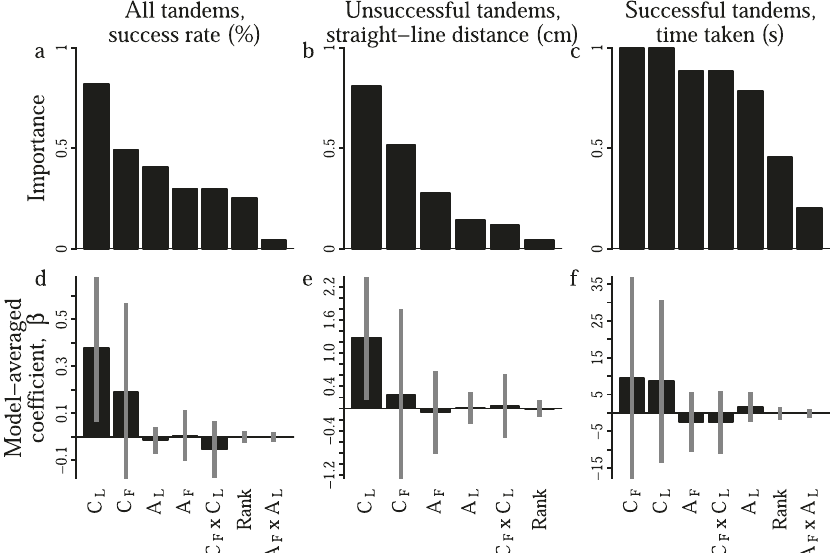
Fig. 4 Model averaging shows that tandem performance depends chie fl y upon the number of baseline emigrations in which the leader acted as a leader, C L . a – c Relative predictor importance, and d – f model-averaged coef fi cients across all models in the 95% con fi dence set. Bars & errors represent coef fi cient means & standard errors for each predictor; C consistency, A tandem activity. Subscripts indicate the task. `Rank' indicates the within- emigration tandem